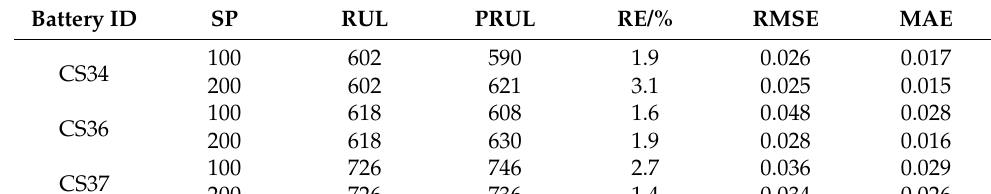
Table 1. Performance on the CALCE dataset.